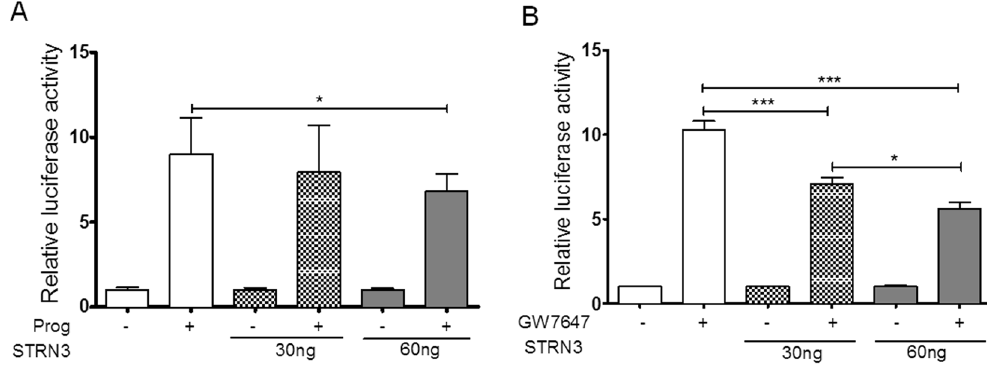
Figure 4. STRN3 inhibits PR and PPAR α trans-activation. ( A ) HEK293T cells were transfected with Flag-PR (30 ng) along with its respective PRE-Luc reporter (15 ng) and with 30 ng or 60 ng of Flag-STRN3. The cells were stimulated with 1 μ M progesterone (or vehicle) for 24 h as indicated. ( B ) HEK293T cells were transfected with Flag-PPAR α (30 ng) along with its respective PPRE-Luc reporter (15 ng) and with 30 ng or 60 ng of Flag-STRN3 (or empty vector so that total transfected DNA is 110 ng). The cells were stimulated with 1 μ M GW647 (or vehicle) for 24 h as indicated. The graphs represent pool data from three independent